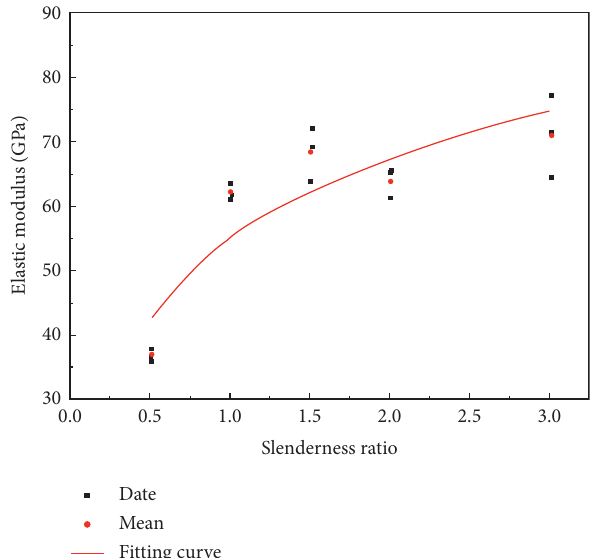
Figure 5: The elastic modulus versus the slenderness ratio ( D ).